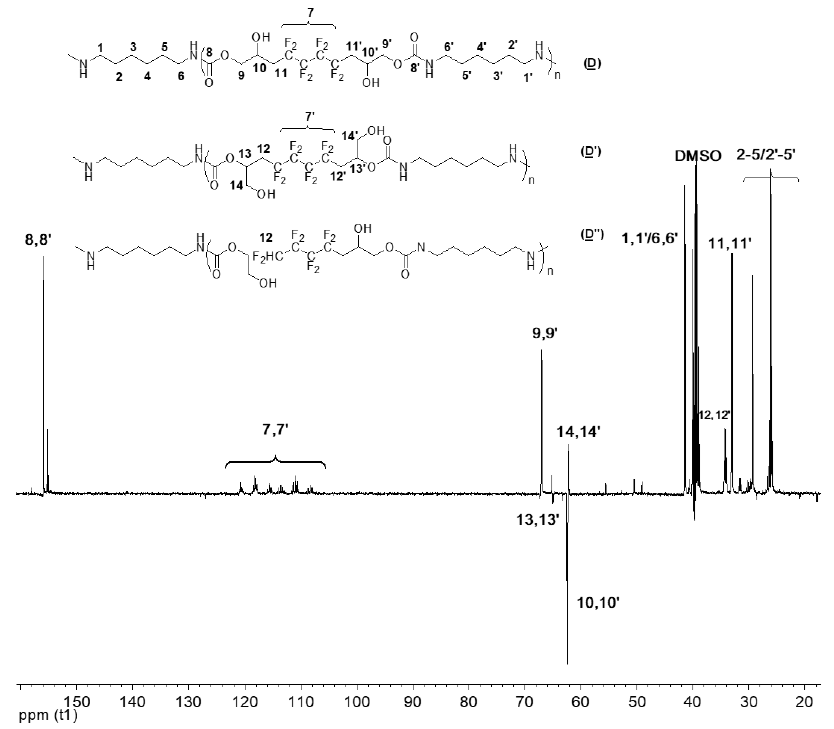
Figure 11. 13 C NMR (DEPT 135) spectrum of the synthesized FPHUs ( D ), ( D′ ), and ( D″ ) (DMSO, 20 °C, 100.6 MHz).